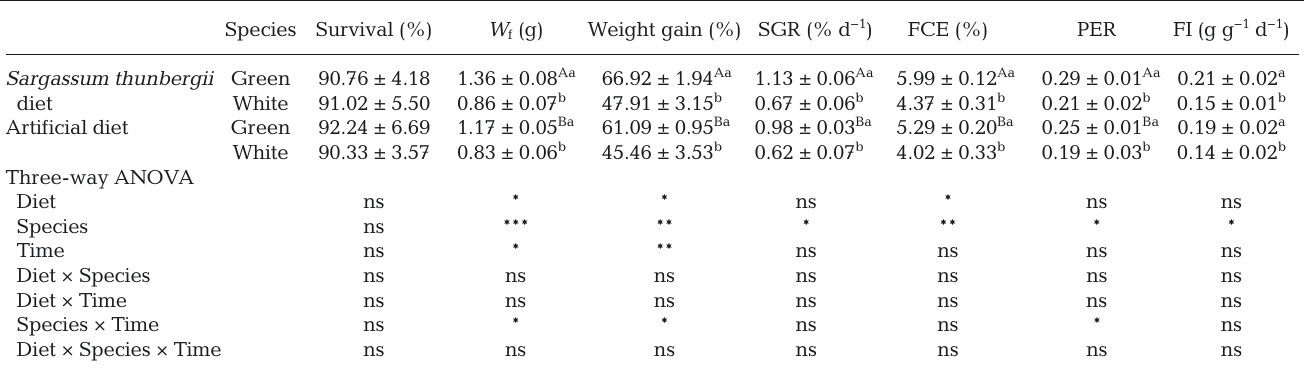
Table 2. Growth performance and feed utilization of green and white sea cucumber fed the experimental diets. W f : final dry weight; weight gain = (